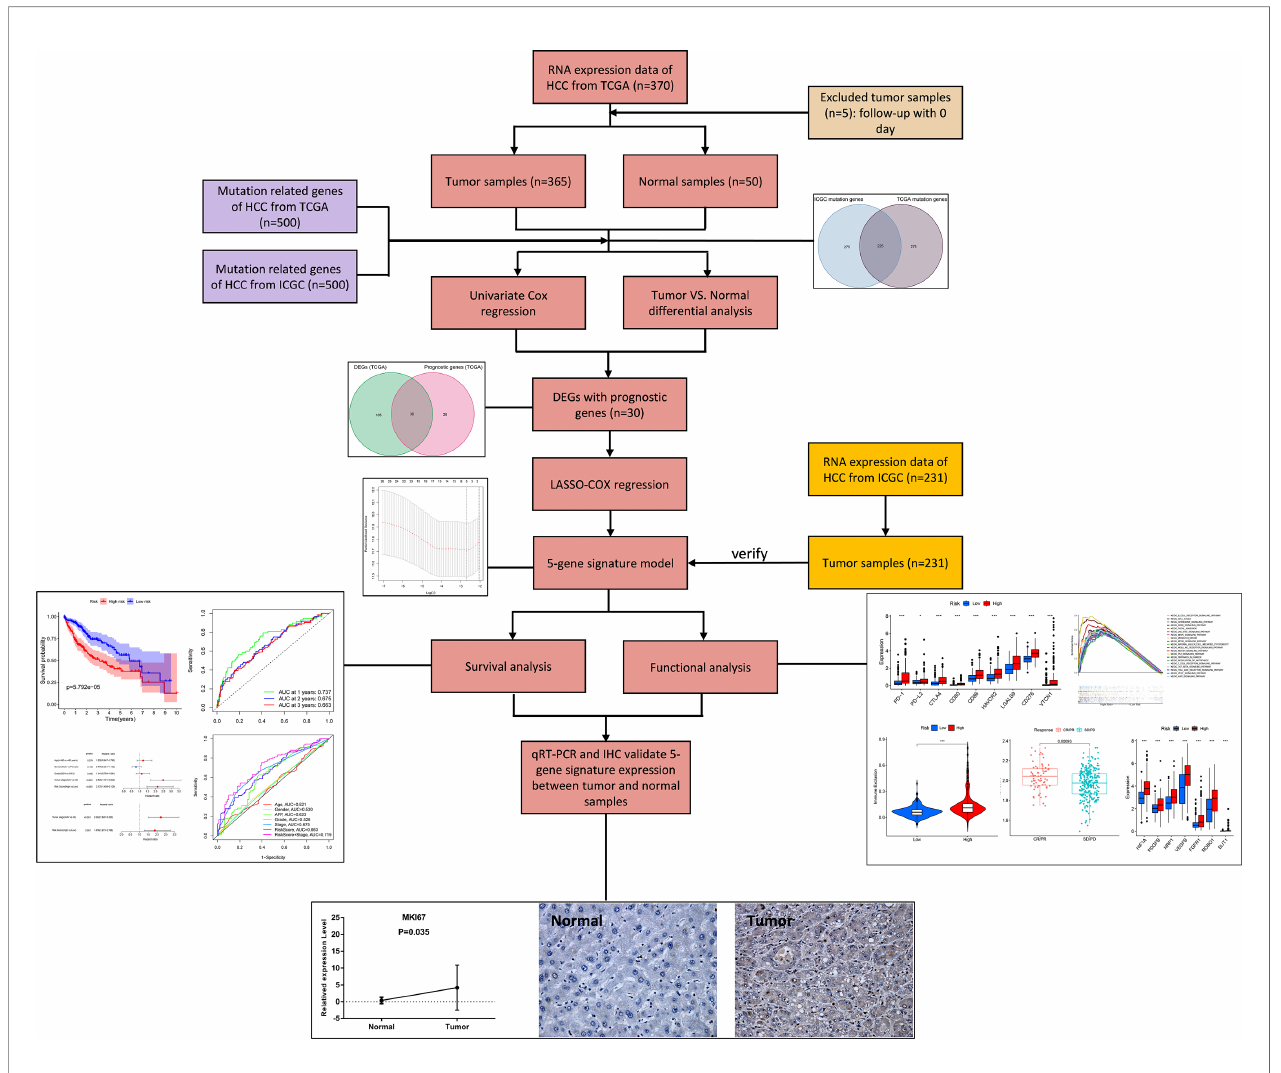
FIGURE 1 | Work fl ow graph for this